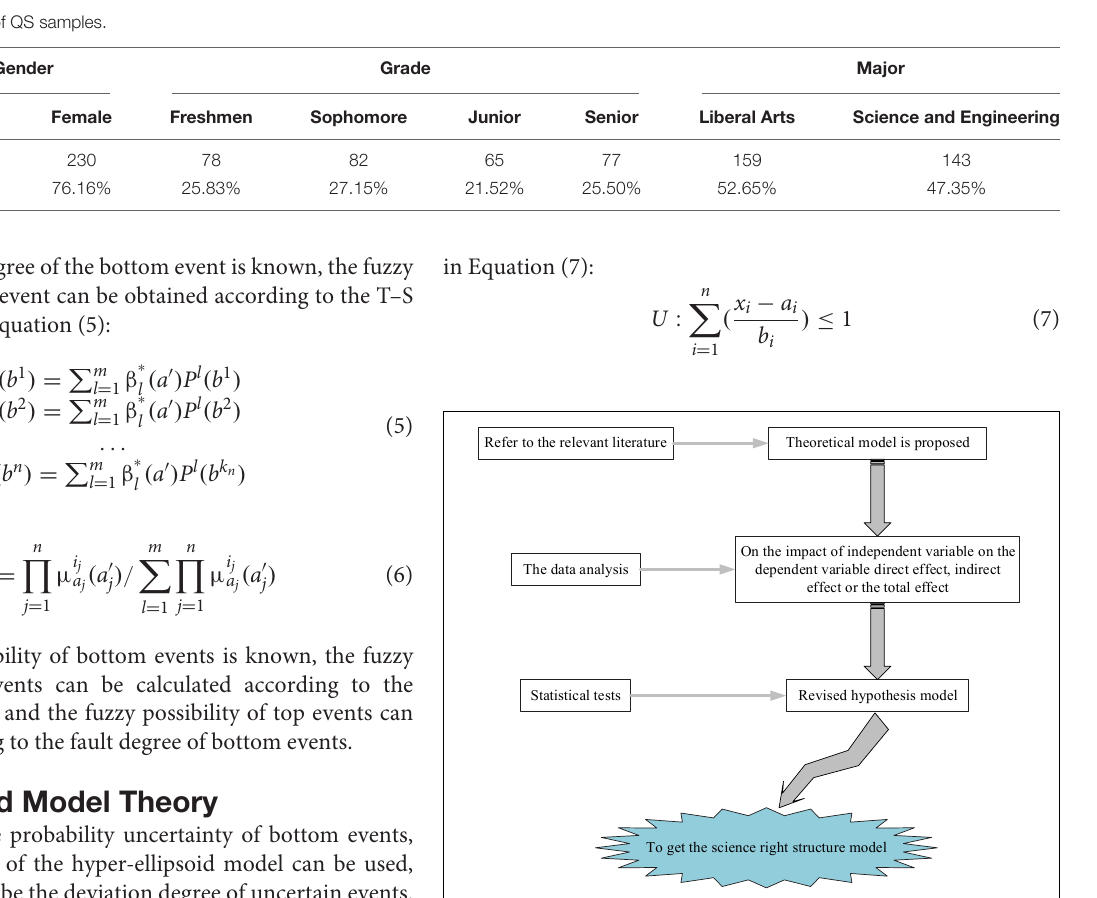
FIGURE 7 | The basic process of structural equation model